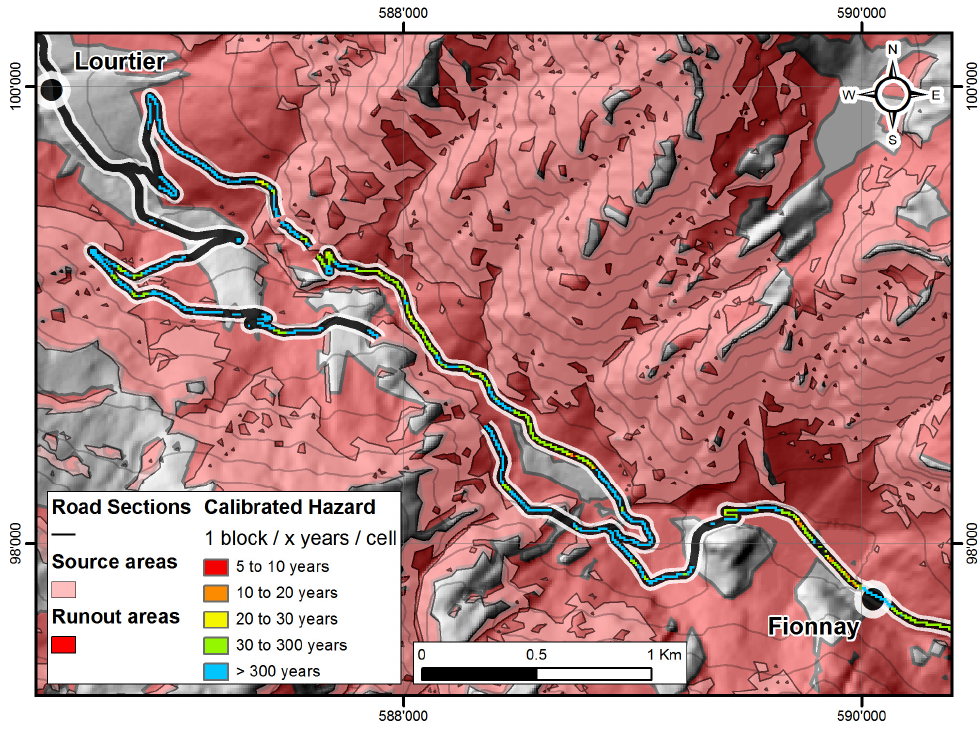
Fig. 9. Inverse hazard once the calibration has been performed, focused along the road section of Fionnay. Gaps along the section correspond to tunnels. (Hillshade and 10m isohypses: ©2008 swisstopo) Figure 9. Inverse hazard once the calibration performed, focused along the road section of 3 Fionnay . Gaps along the section correspond to tunnels. (Hillshade and 10 m isohypses: 4 ©2008 swisstopo) 5